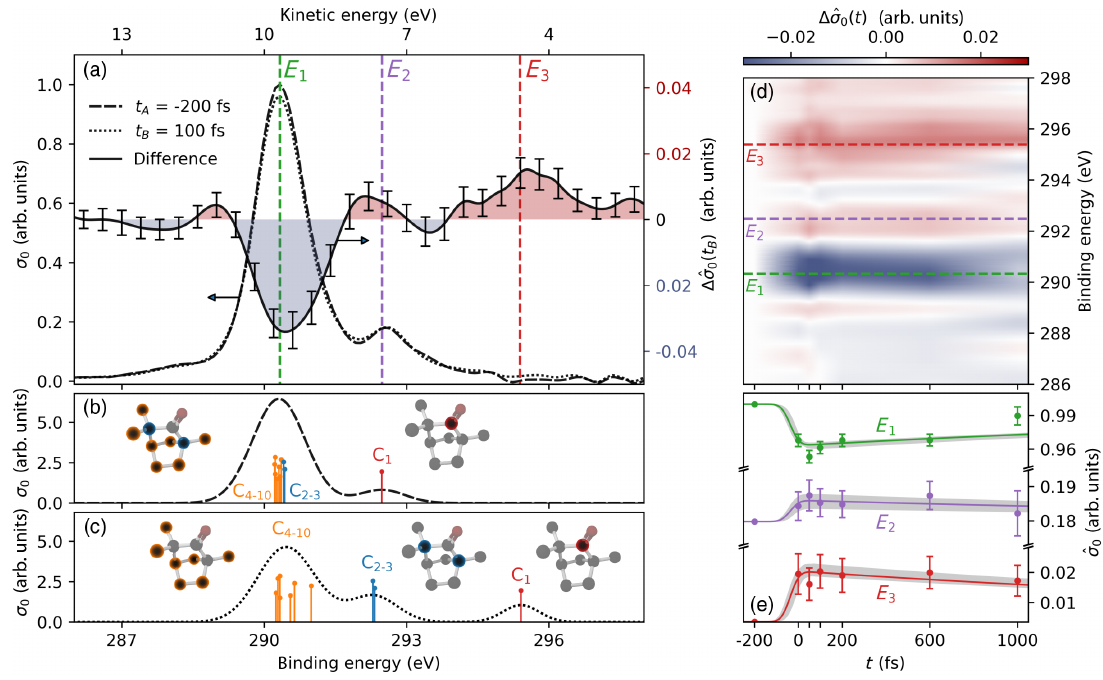
− 200 fs (dashed line) and t 100 fs (dotted line), difference Δ ˆ σ ˆ σ − ˆ σ FIG. 3. (a) PES at t 0 ð t B Þ ¼ 0 ð t B Þ 0 ð t A Þ of the sliding A ¼ B ¼ averaged PES ˆ σ 0 (solid line and 1 σ error bars). (d) Δ ˆ σ 0 ð t Þ for all the measured delays t . (a),(d) The energies E 1 , E 2 , and E 3 are indicated by dashed green, violet and red lines, respectively. (e) ˆ σ 0 ð t Þ for E 1 , E 2 , and E 3 indicated by green, violet, and red dots, respectively, along with the 1 σ error bars. A single exponential of 3.3 ps decay time, corresponding to the measured lifetime of the 3 s Rydberg state [9] is shown with solid lines. The amplitude and time zero of this exponential are fitted to the experiment and the 1 σ confidence interval of the fit is represented by a gray shaded area. (b),(c) Calculated binding energies for the ground state (b) and excited 3 s Rydberg state (c), indicated by red (C 1 ), blue (C 2 , C 3 ), and orange (from C 4 to C 10 ) dots and vertical lines, where the vertical offset is intended for clarity only. Theoretical PES in (b) and (c) are shown with dashed and dotted line,